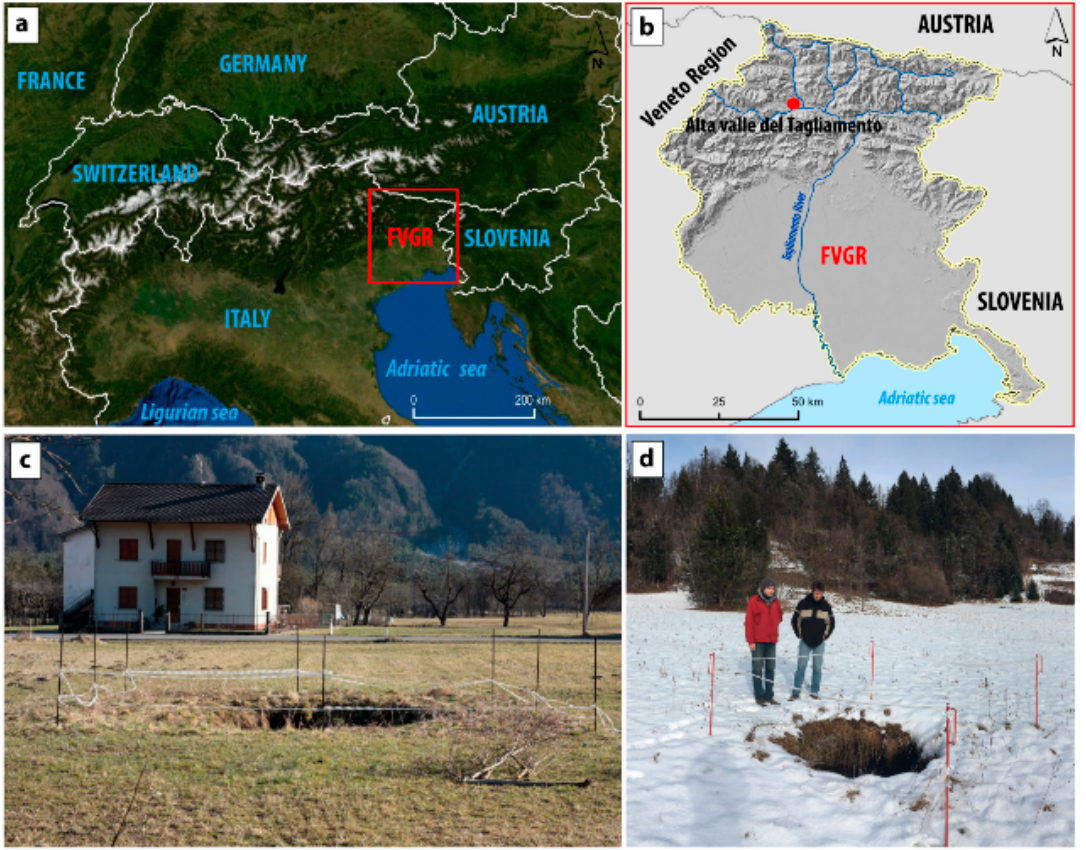
Figure 1. ( a ) Study area location in the European environment; ( b ) location of the study area (red dot) in the FVGR correspond to the Quins hamlet, in blue the Tagliamento River; ( c ) a cover collapse sinkhole occurred in 2013 in the western side of Enemonzo municipality; ( d ) a cover collapse sinkhole occurred in 2017 on the north-eastern side of Enemonzo municipality.